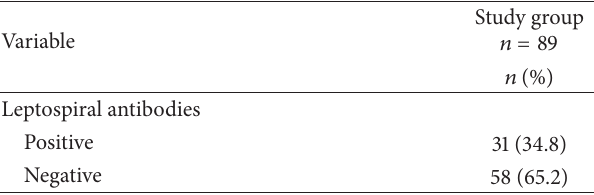
Table 2: Prevalence of leptospiral antibodies among municipal service workers.